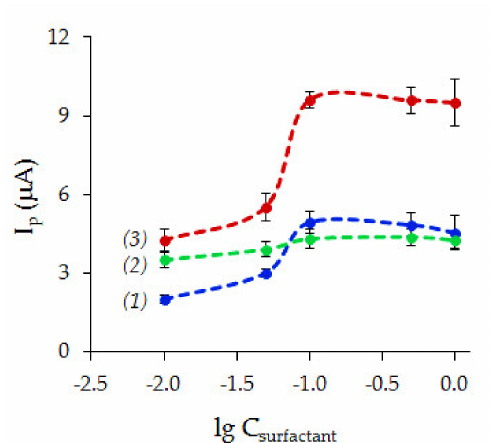
Figure 4. Dependence of the nitrite oxidation peak current on the logarithm of surfactant concentration (mM) used for the FCVE modification: cetyltrimethylammonium bromide (CTAB) ( 1 ), sodiumdodecyl sulfate (SDS) ( 2 ) and TrX100 ( 3 ). Solution: BRB (pH 3) + 0.02 mM NO 2 −